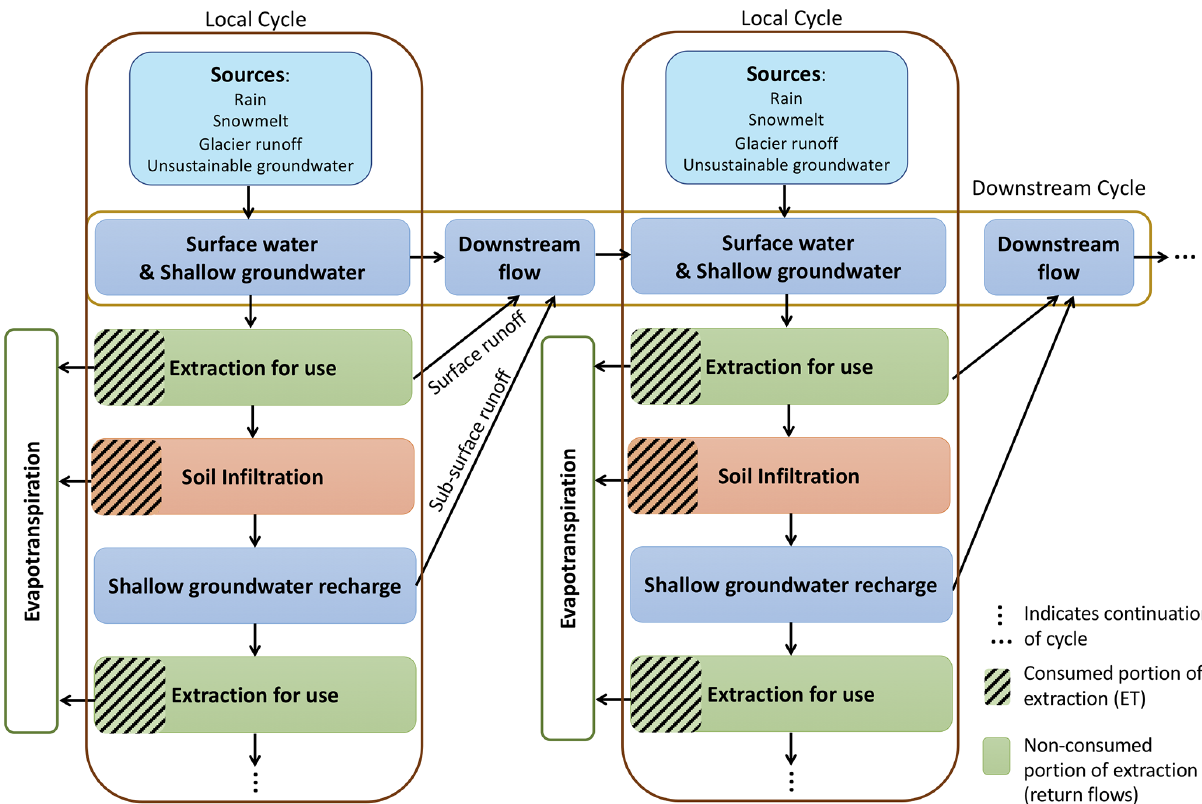
Figure 2. Schematic representation of the primary source component tracking. All surface water and shallow groundwater are composed of the four primary sources: rain, snowmelt, glacier runoff, and unsustainable groundwater. When surface water and/or shallow groundwater is extracted for use, this initiates both a local cycle and a downstream cycle of water use and re-use. In the example shown here, water is extracted and applied to soils (irrigation). A portion of the extracted water and a portion of the soil water become evapotranspiration (the consumed portion, shown with hashes). Some of the water applied to soils percolates to the shallow groundwater pool. Water from the shallow groundwater pool can be extracted again, continuing the local water re-use cycle. Water extracted for use, and water from the shallow groundwater pool, generate runoff that moves downstream. This initiates a downstream cycle in which this water can be re-extracted for use from the surface water system. Downstream cycles intersect with local cycles, as water from the four primary sources are input into every locality. Figure modified from Grogan et al.